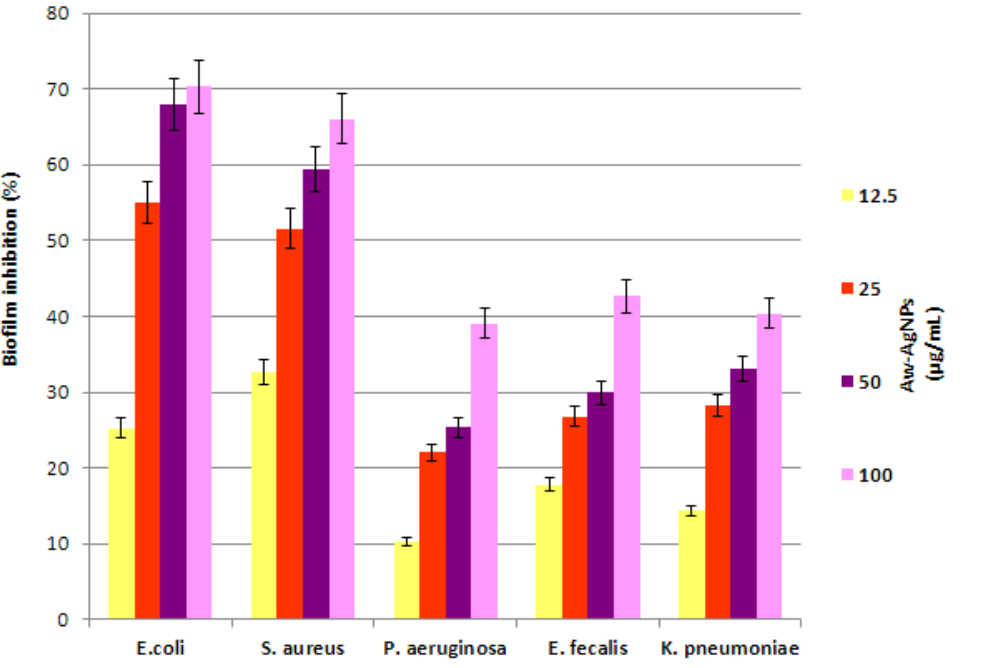
Figure 6. Anti-biofilm activity, represented by biofilm inhibition (%), of silver nanoparticles (ug/mL) synthesized from Ajwa dates extract against different standard bacterial strains. Significant difference ( p < 0.05) was observed by one-way ANOVA test.